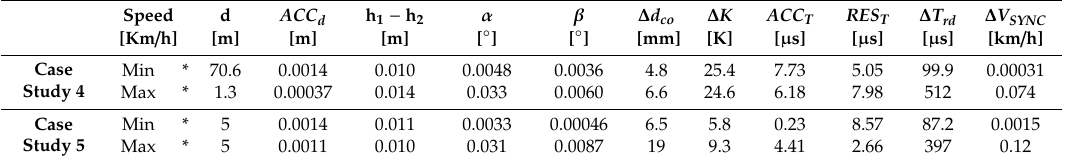
Table 4. Values of the set of random parameters associated to the maximum and minimum u ∆ V case studies 4 and